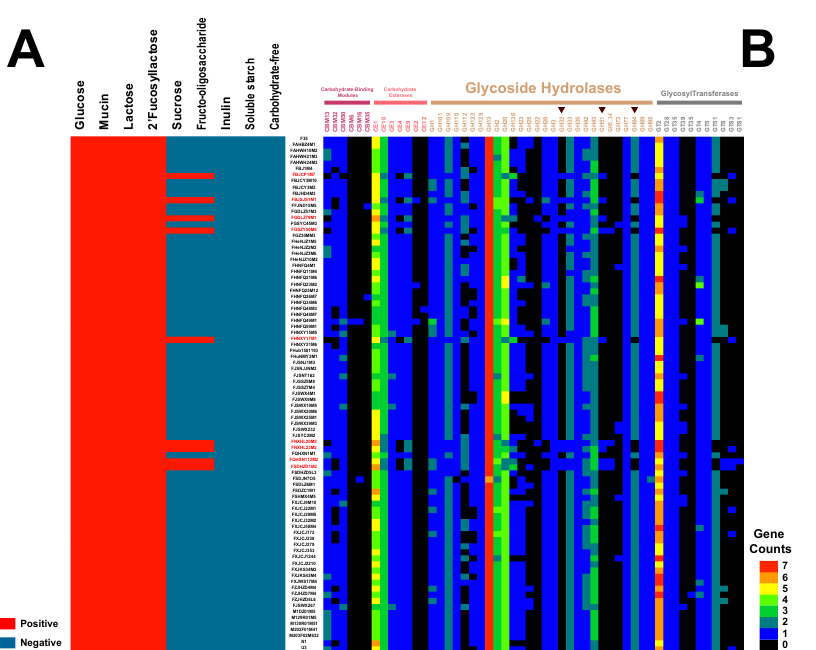
Figure 6. The phenotypes of B. bifidum strains that utilized host-derived and plant-derived glycans ( A ). The distribution and number of glycoside hydrolase (GH), carbohydrate esterase (CE), and glycosyltransferase (GT) family genes. Gene copy number was indicated by color ranging from dark (absent) to red ( B